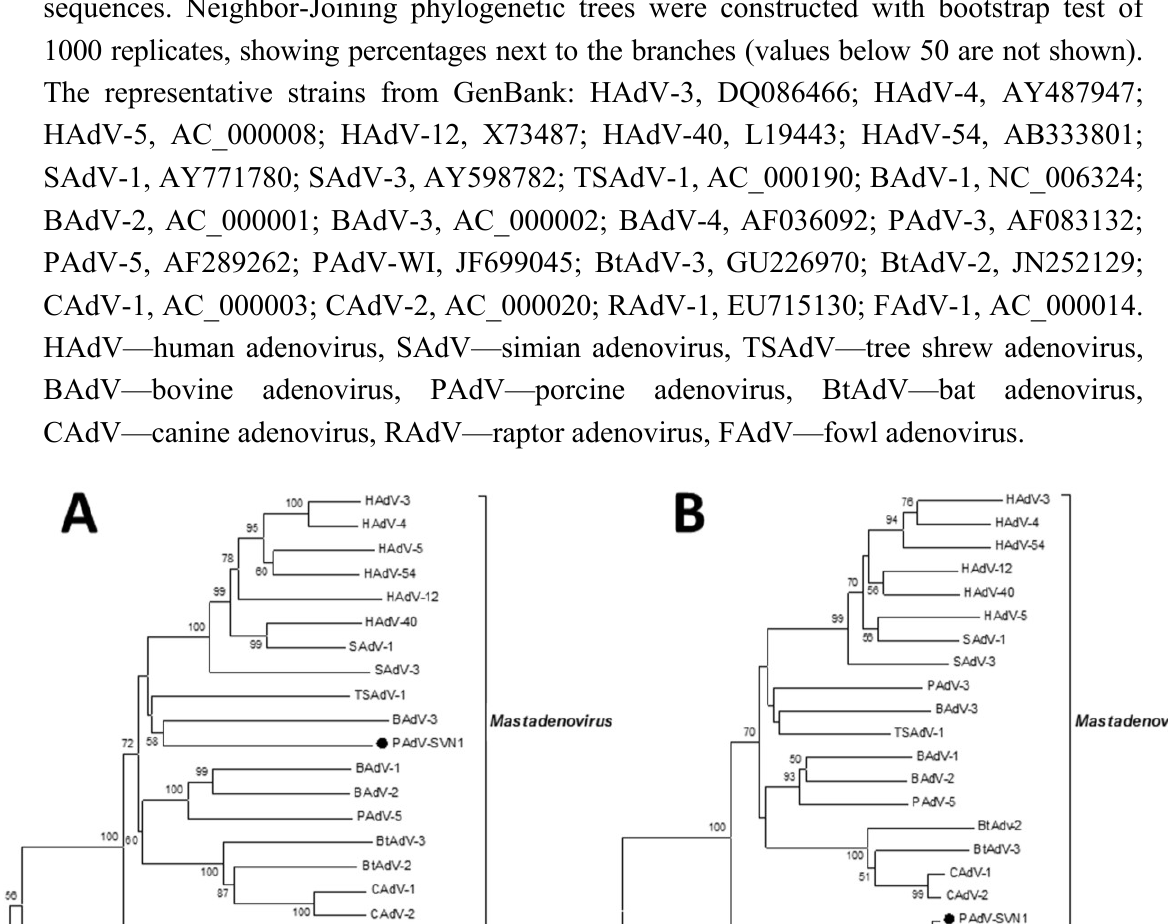
Figure 4. Phylogenetic tree of partial polymerase ( A ) and hexon ( B ) deduced amino acid sequences. Neighbor-Joining phylogenetic trees were constructed with bootstrap test of 1000 replicates, showing percentages next to the branches (values below 50 are not